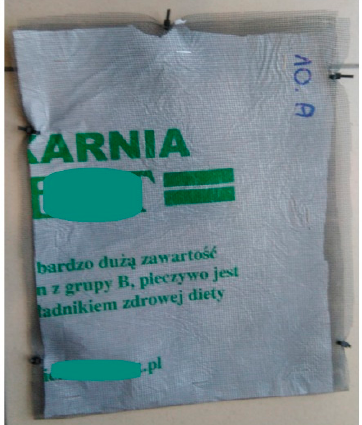
Figure 2. The appearance of a sample sandwiched between two layers of mesh [photo F. Markowicz].